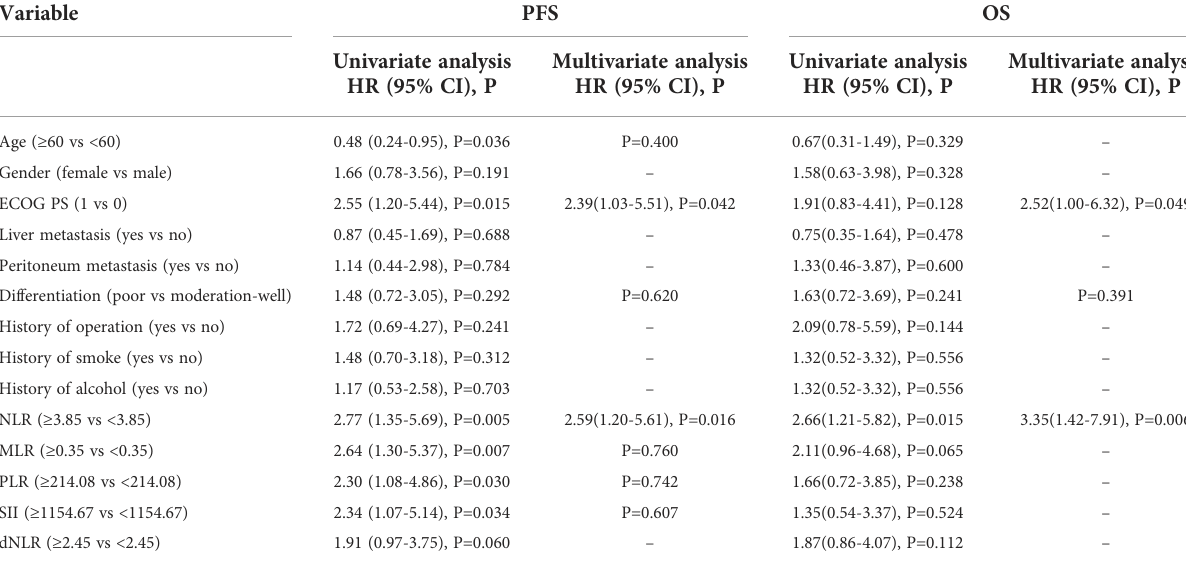
TABLE 2 Univariate and multivariate analyses of the association between baseline characteristics and survival in the clinical trial